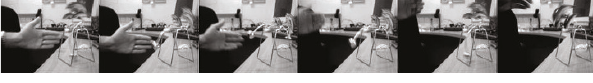
Figure 15: Frames from reconstructed clip.